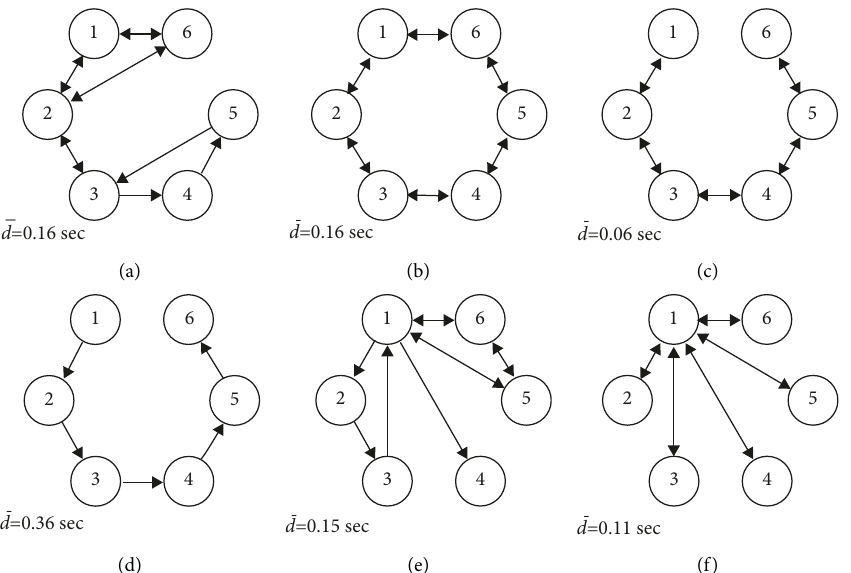
Figure 3: Communication topology of a multiagent system. (a) d � 0 . 16 sec. (b) d � 0 . 16 sec. (c) d � 0 . 06 sec. (d) d � 0 . 36 sec. (e) d � 0 . 15 sec. (f) d � 0 . 11 sec.